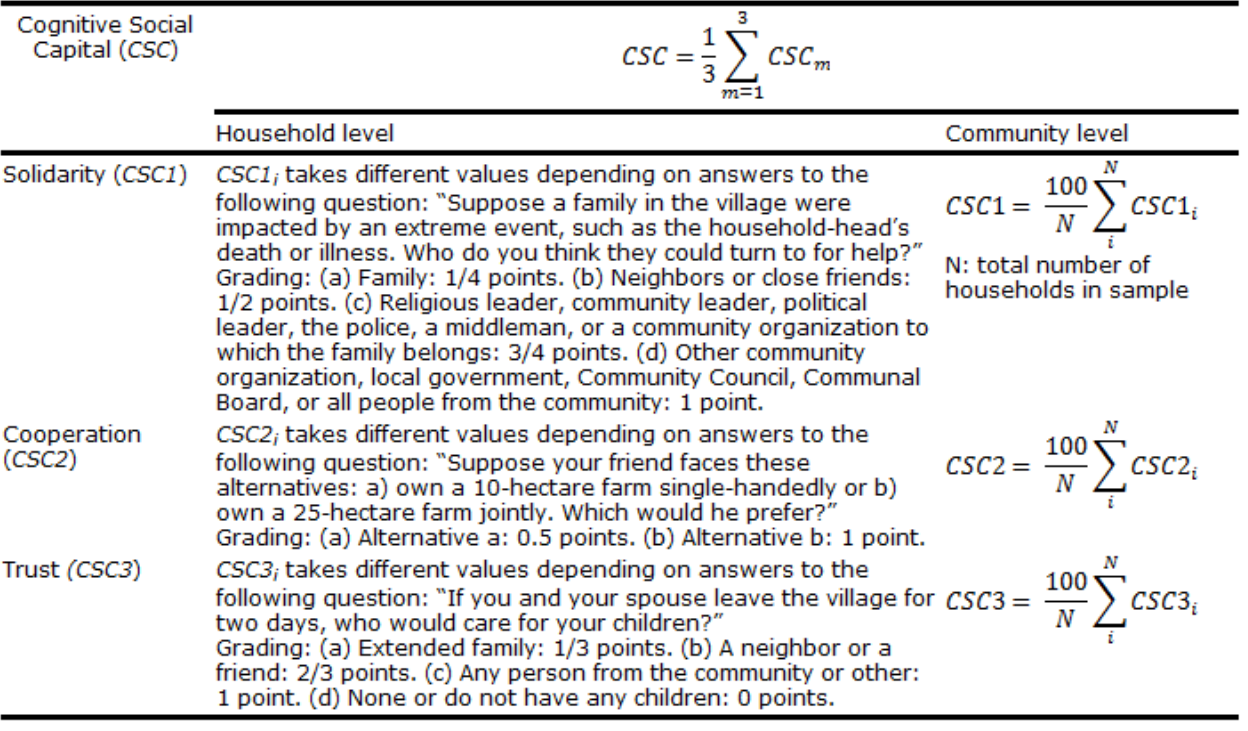
Table 5 . Calculation of cognitive social capital indicator and